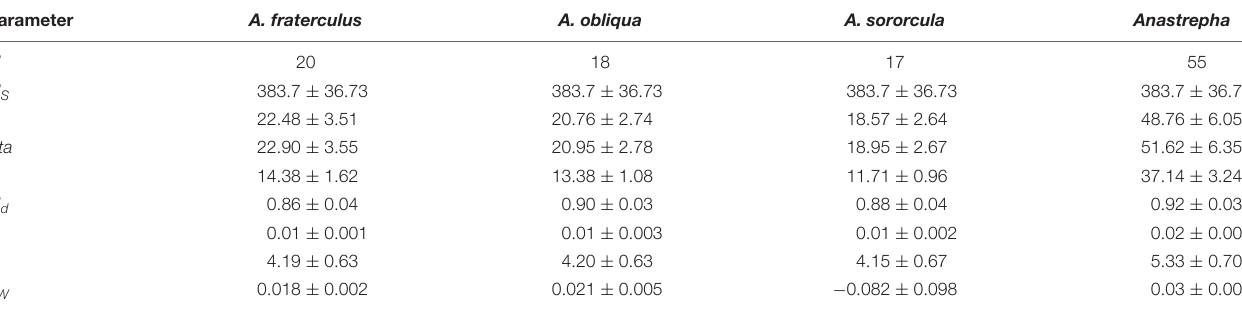
TABLE 1 | Descriptive parameters for haplotype and nucleotide diversity.